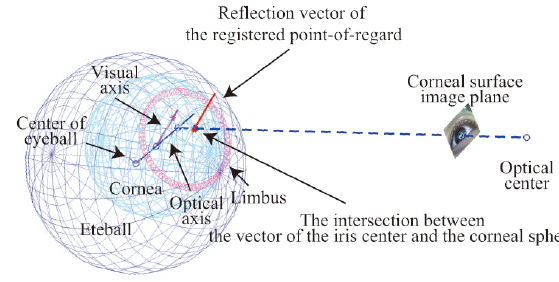
Figure 6 . The intersection between the center of the iris, the corneal sphere, and the visual axis.